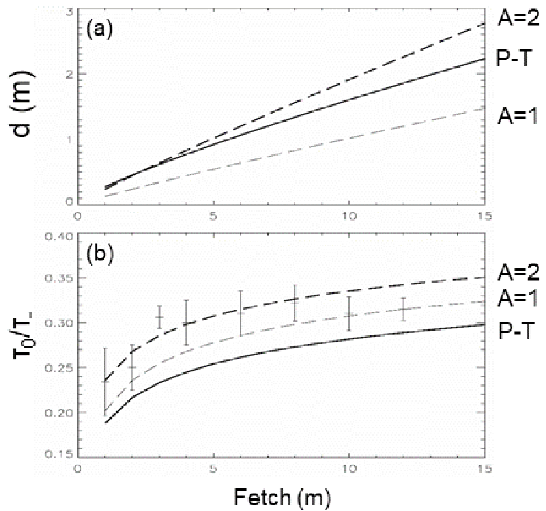
Figure 1. Theoretical IBL depths (a) and surface stress (b) as a function of fetch for the rough-to-smooth transition case of Bradley (1968). Solid curves – Panofsky and Townsend (1964) ap- proach; dashed curves – Jensen (1978) approach with A = 1 (thin dash) and A = 2 (thick dash) as indicated. Error bars in (b) repre- sent the range of observed values from Bradley (1968), and surface stress values are normalized by the upstream